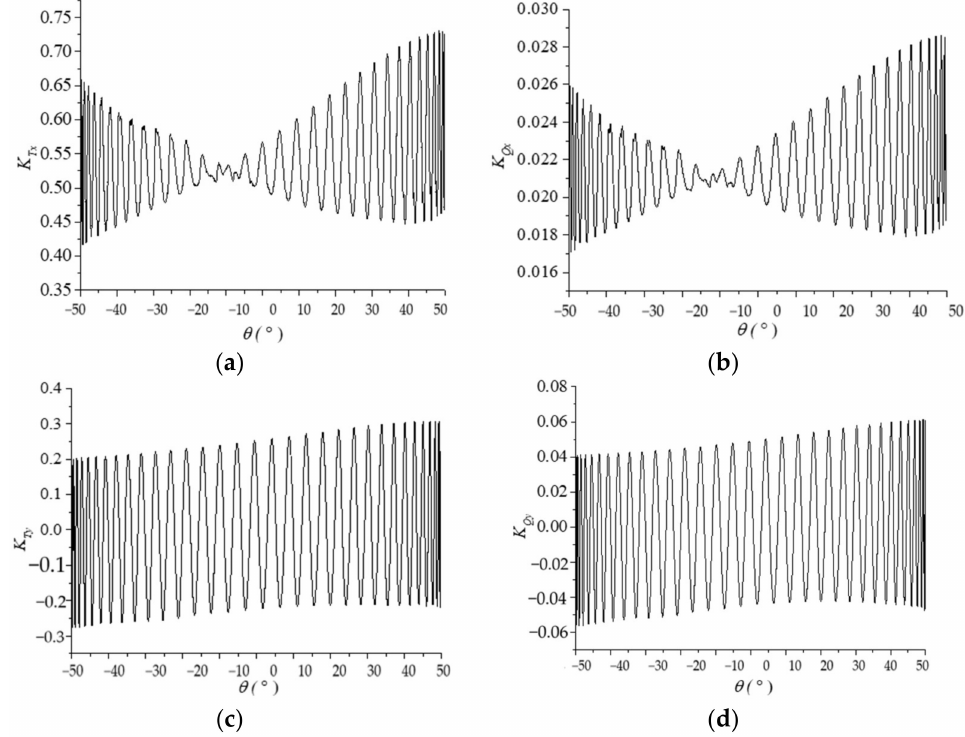
Figure 15. Load of the single blade under maneuvering conditions ( J = 0.2): ( a ) K TPx ; ( b ) K QPx ; ( c ) K TPy ; ( d ) K QPy